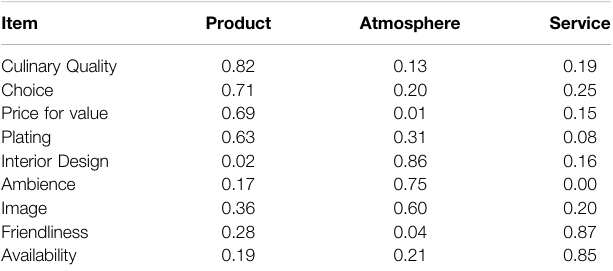
TABLE 3 | Table of fi xed effects from a linear-mixed-effects model predicting the A-weighted sound pressure level through reverberation time ( T 20,occ ) and the number of restaurant guests ( N Guests